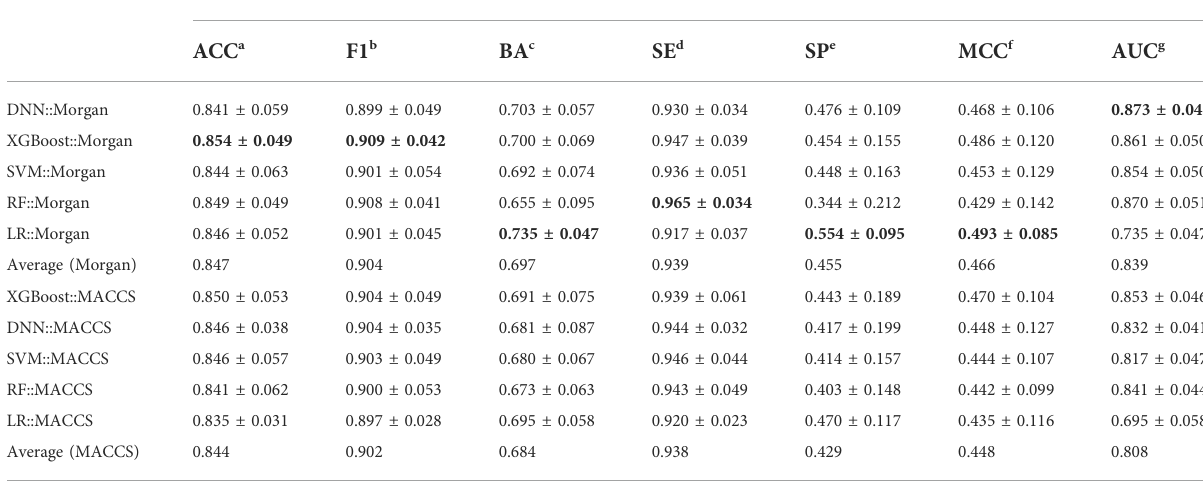
TABLE 2 The overall predictive performance of fi ngerprint-based models for the test sets.